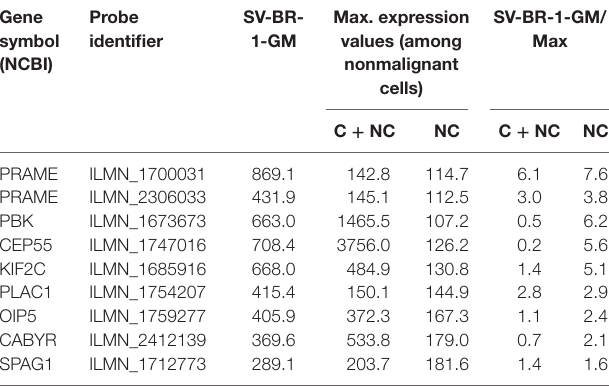
TaBle 3 | Cancer/testis antigen expression in SV-BR-1-GM cells. gene